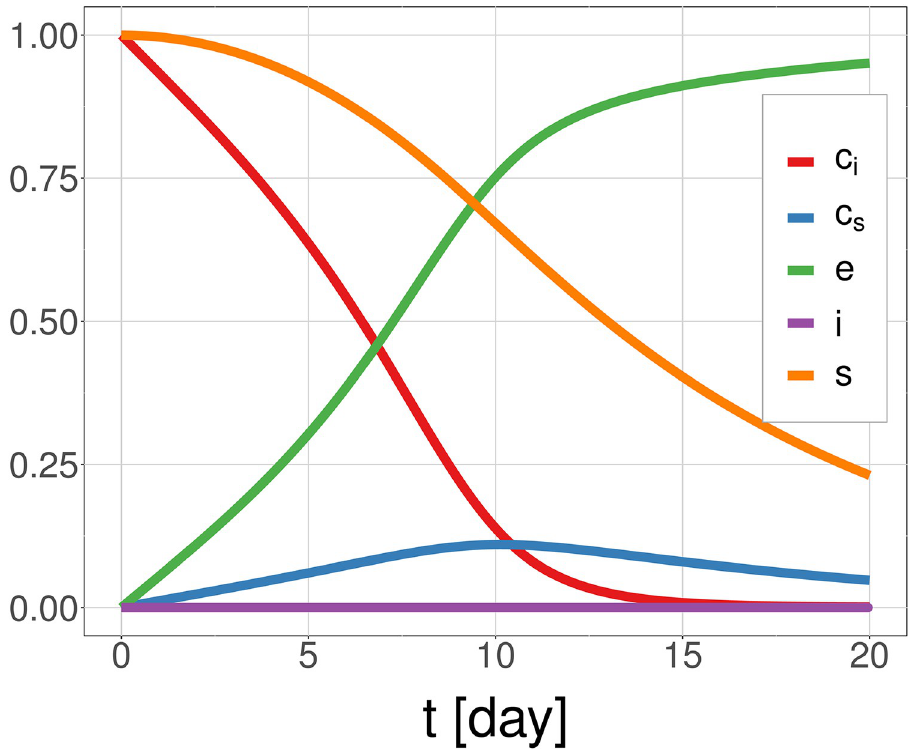
Fig 2. Solution of the subcellular model for a cell moving at a specified velocity through the pH gradient of the corneum, using an effective concentration of KLK enzyme: s 0 = 10 μ M, e enzyme by a factor of 10 − 4 (from 0.7 μ